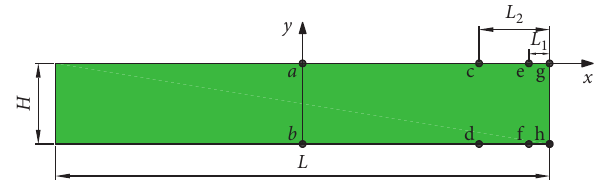
Figure 2: Configuration of the foundation